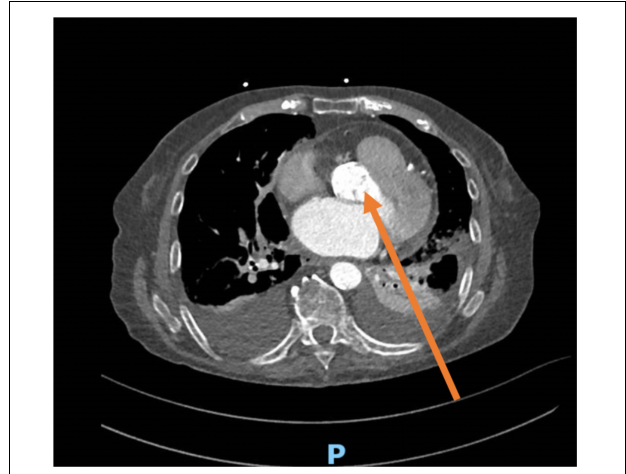
FIGURE 4 | CT scan from the same patient showing the alignment of the Doppler beam in the posterior thoracic view toward the aortic valve (arrow). The transducer is positioned between posterior intercostal spaces, parallel to the